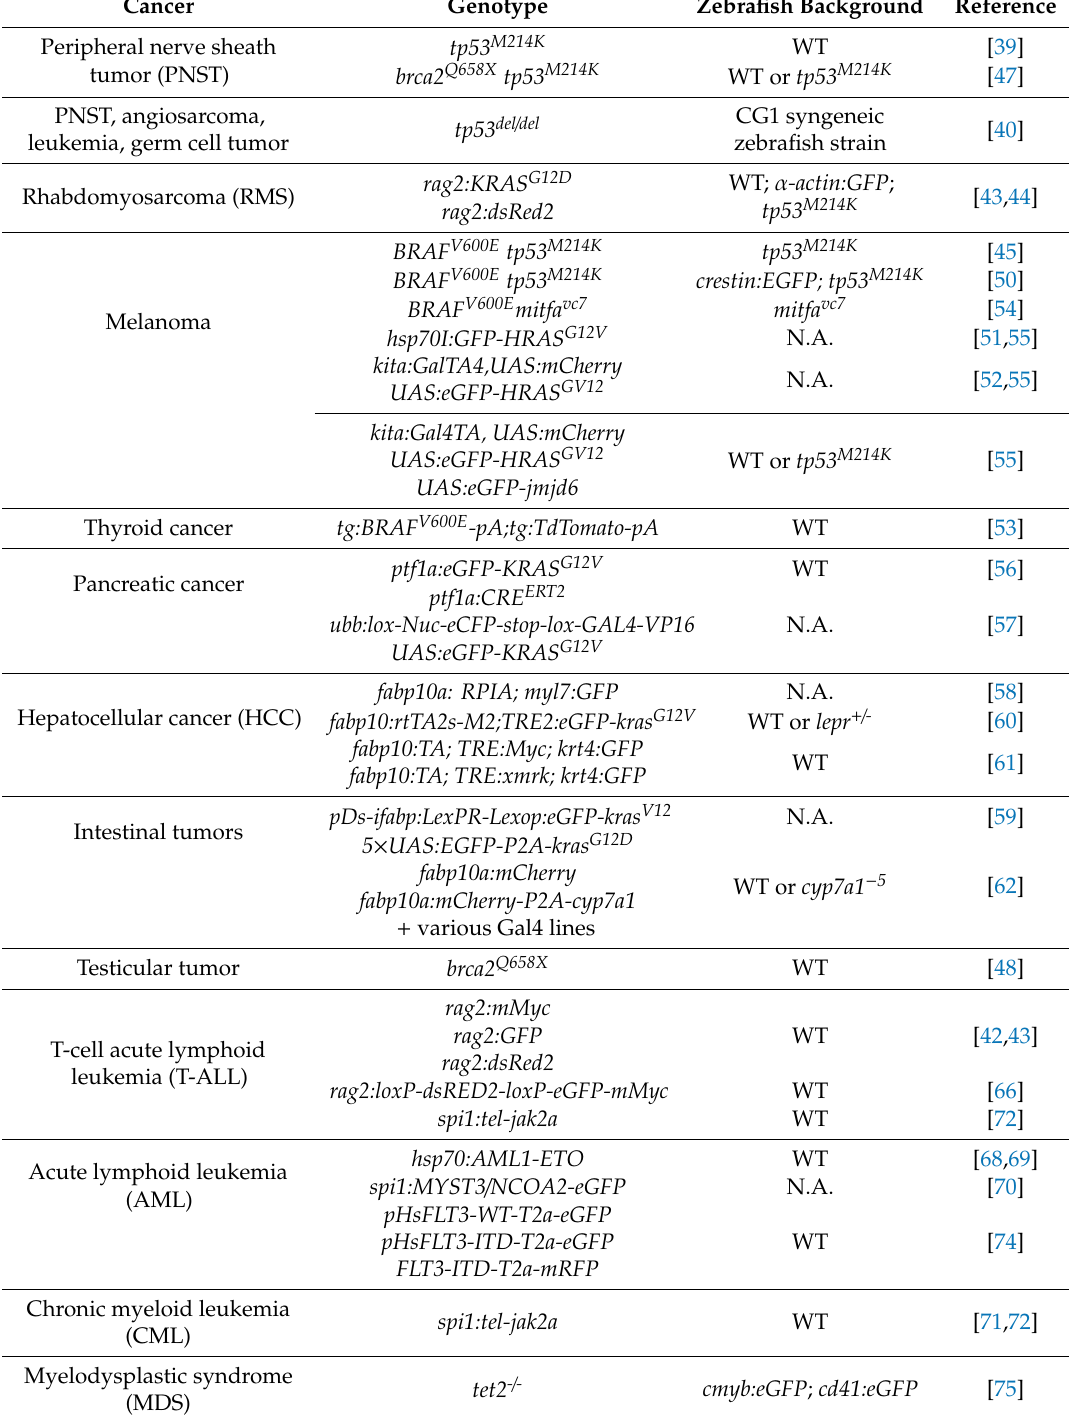
Table 1. Genetic models of cancer in the